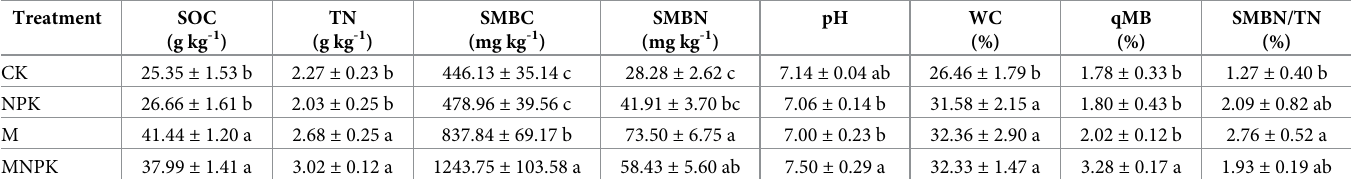
Table 1. Basic properties of soil samples under different fertilizer treatments. Treatment